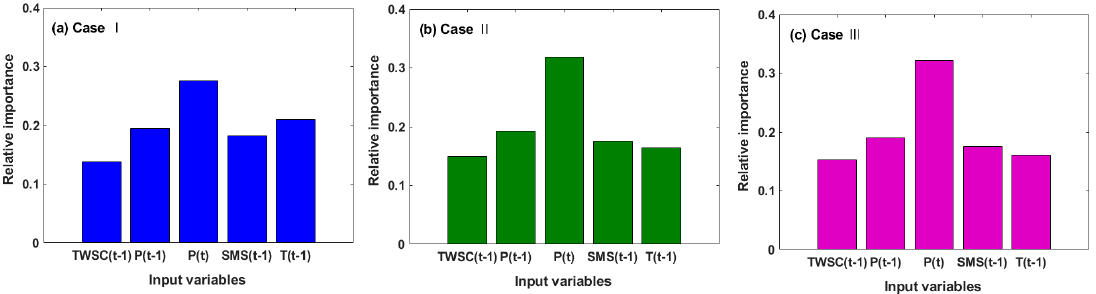
Figure 8. Relative importance of the input variables identified by the ANN model. ( a ) Case Ⅰ, ( b ) Case Ⅱ , and ( c ) Case Ⅲ .